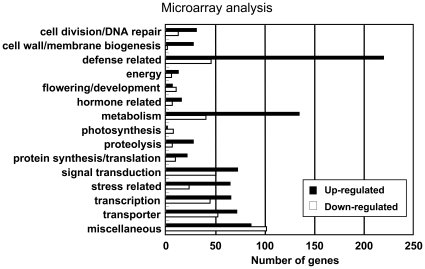
Summary of microarray analysis.Up- and down-regulated genes in type III necrosis were categorized into fifteen functional groups.